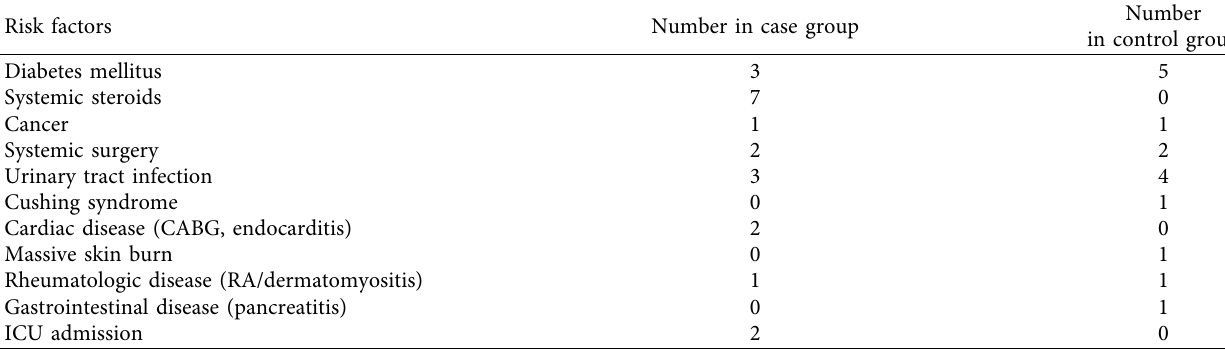
Table 1: Comparison of systemic risk factors of EE patients with and without COVID-19.